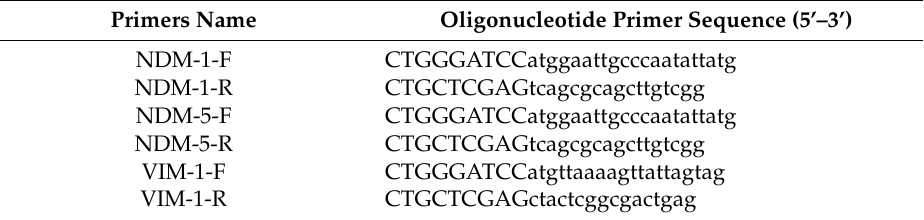
Table 1. The primers for construction, expression and purification of β